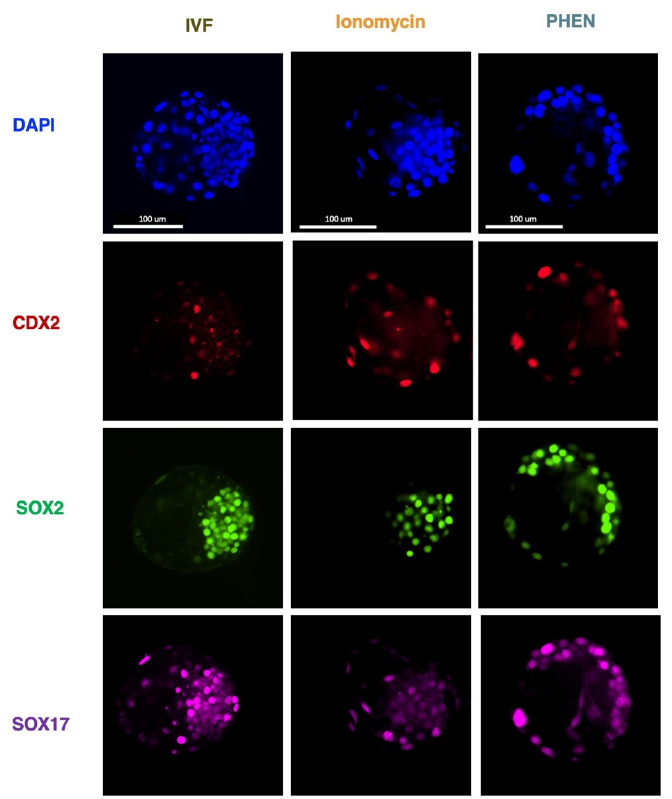
Figure 1. Representative immunofluorescent staining of bovine blastocyst stage embryos of the indicated groups. Scale bars indicate 100 μ m. IVF, in vitro fertilization; PHEN, 1,10-phenanthroline.